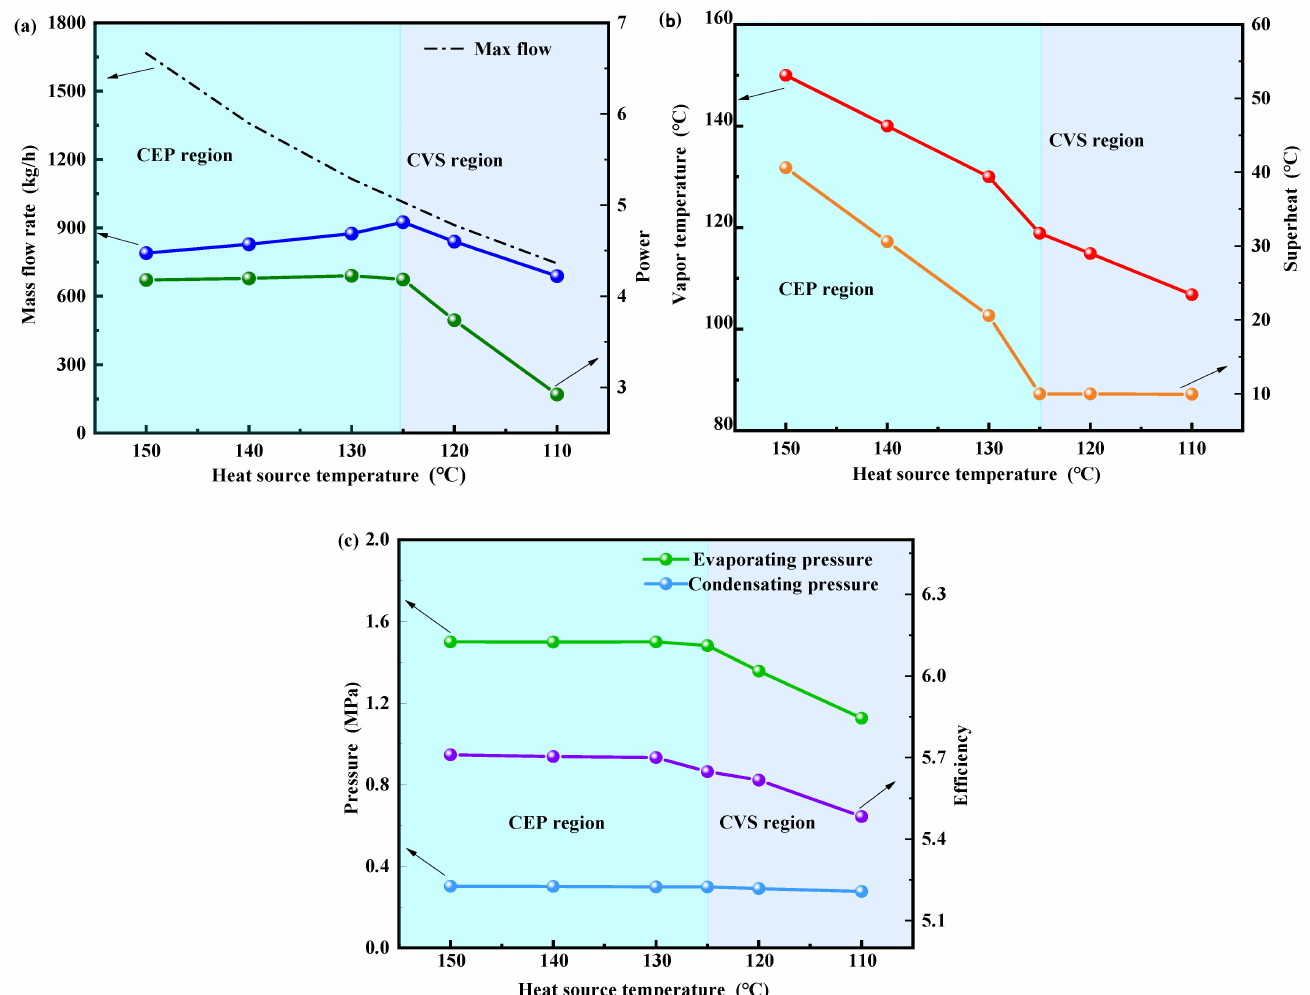
Figure 12. Variation of key parameters of the ORC system with heat source temperature under CVS and CEP modes. ( a ) mass flow rate and power, ( b ) vapor temperature and superheat, ( c ) vapor pressure and thermal